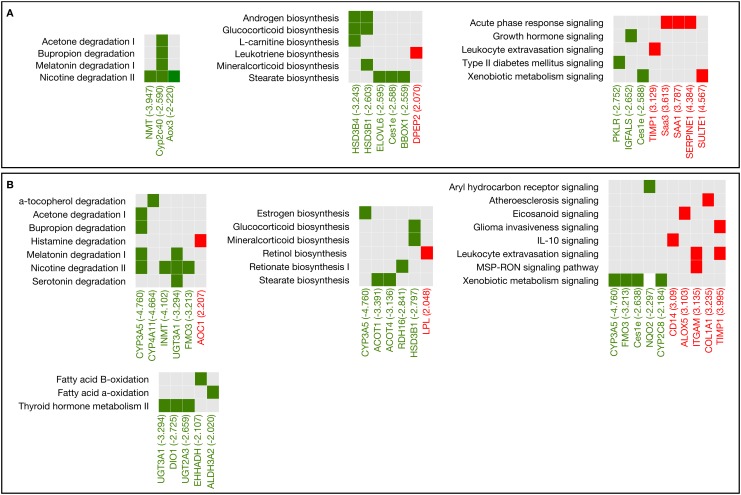
The most representative pathways and the associated differentially expressed genes in two stages of the infection.(A) Comparison between t7 (seven days post-infection) vs t21 (21 days post-infection). (B). Comparison between t0 (Uninfected) vs t21 (21 days post-infection). The fold change of each gene is shown in parentheses. Red squares represent the genes that are up-regulated, belonging to each signaling pathway, green squares represent genes that are down-regulated, whereas gray squares indicate the absence of those genes in that pathway.